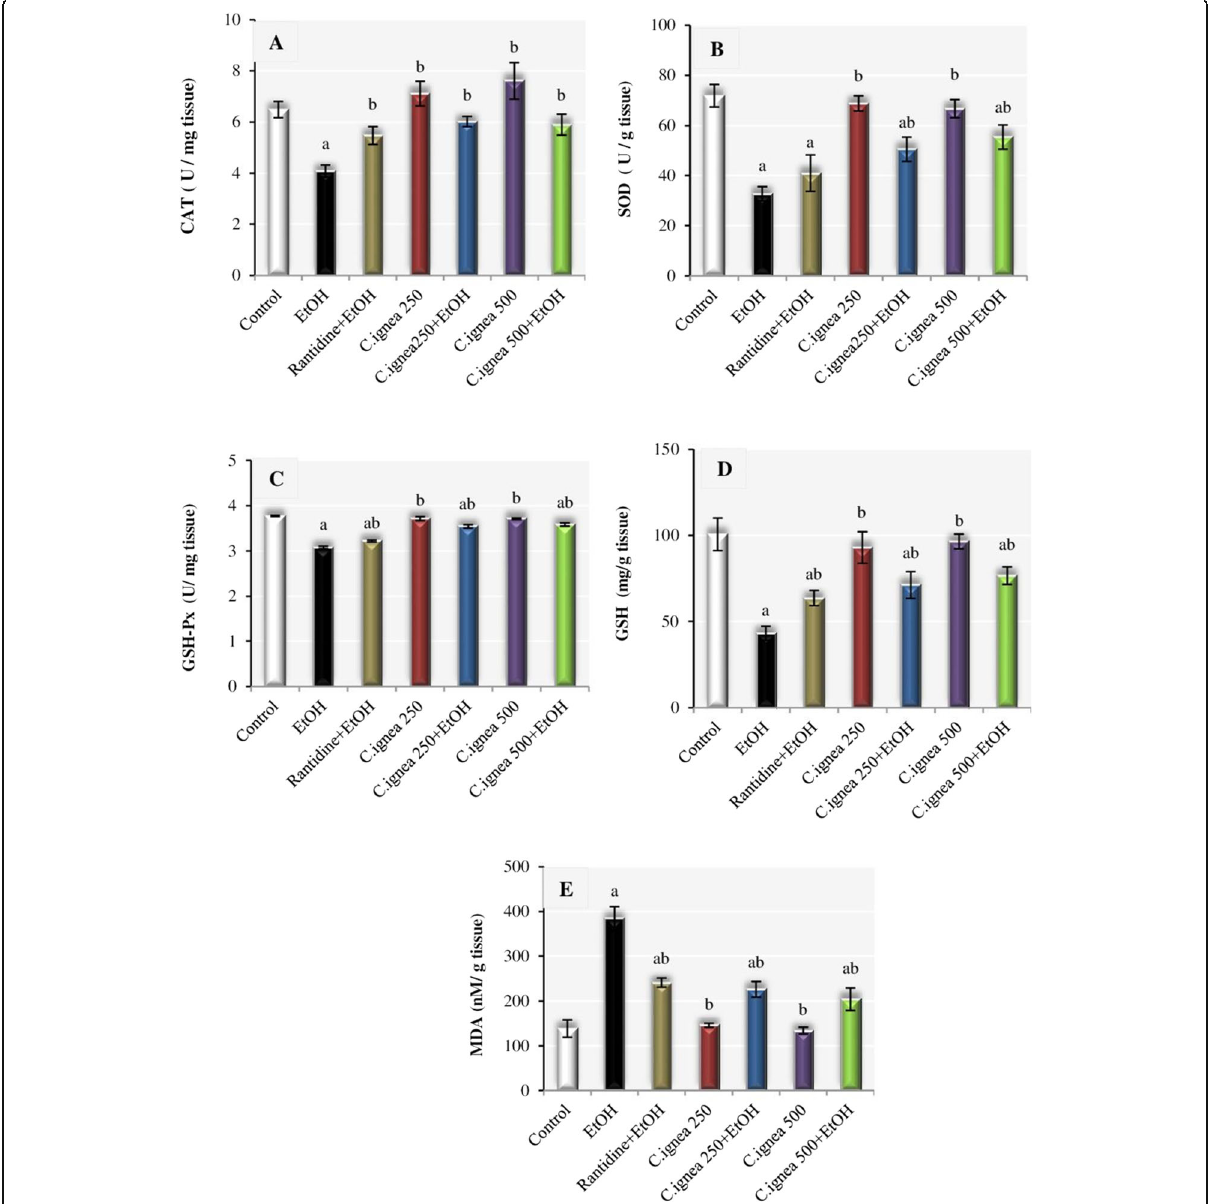
Fig. 5 Effect of C. ignea aerial parts extract on ( a ): CAT, ( b ): SOD, ( c ): GSH-Px, ( d ): GSH, ( e ): MDA in gastric tissue of various experimental groups. Each value represents the mean ± SD for six rats in each group. Statistically significant difference is expressed at p <0.05. a significantly different from normal control group, b significantly different from ethanol